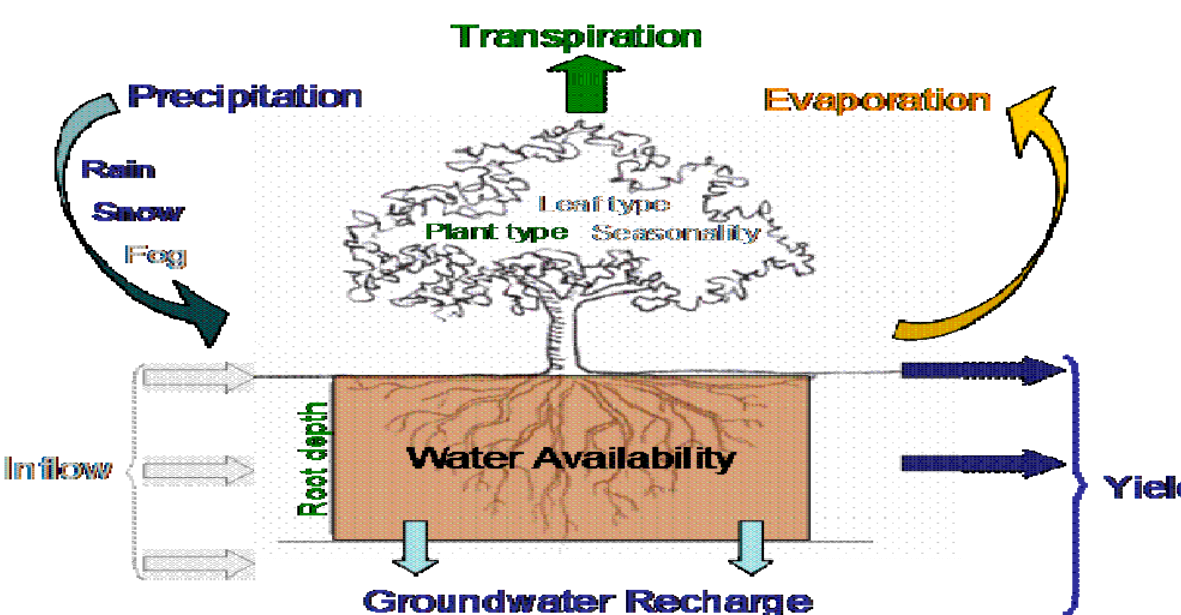
Figure 3. Visualization of the InVEST Water Yield (WY) framework for computing water yield potential per pixel (adapted from InVEST Natural Capital Project) [34].